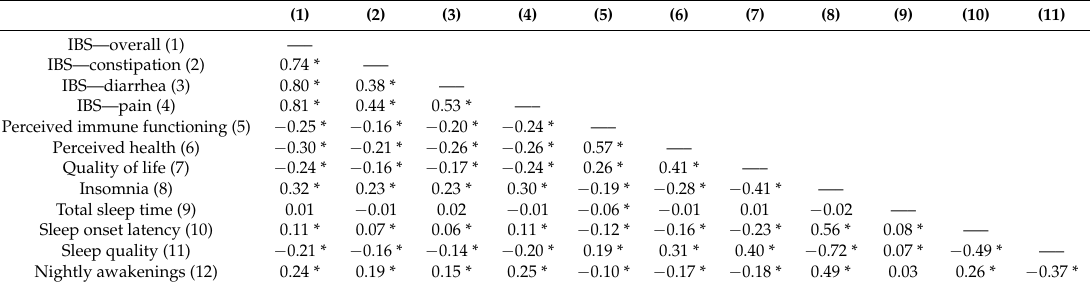
Table 2. Associations between IBS, perceived health and immune status and sleep